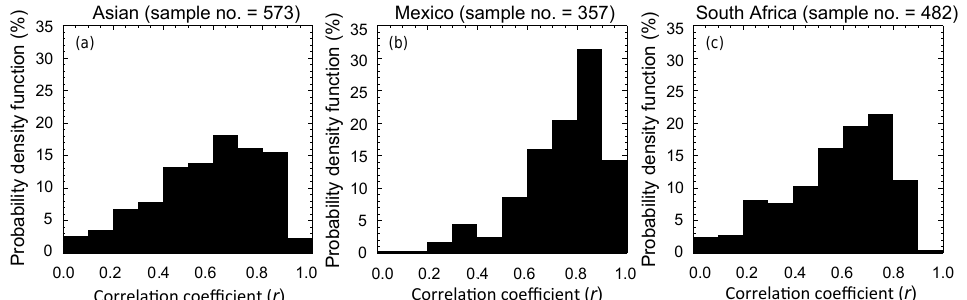
Figure 6. Probability distribution functions (PDFs) of daily spatial correlations over eastern China (a) , Mexico (b) , and South Africa (c) from 2012 to